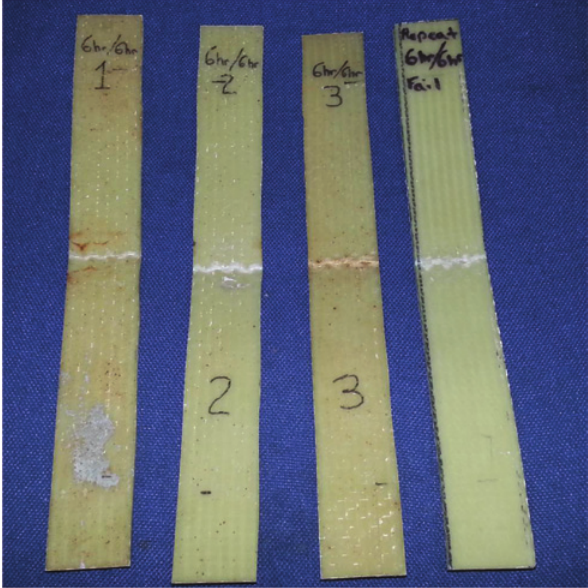
Figure 8: Modes of